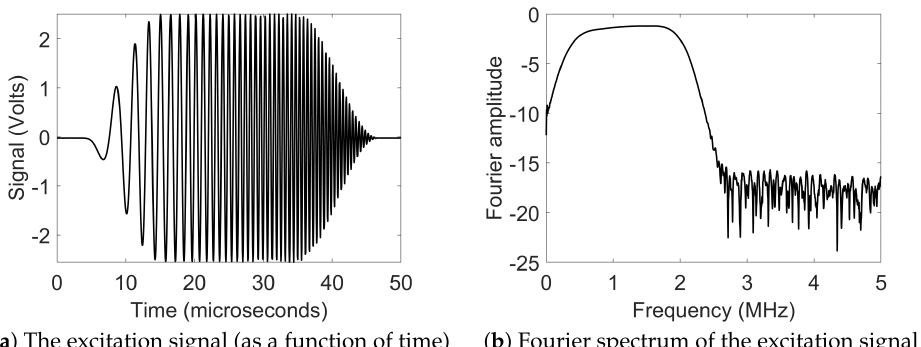
Figure 2. Chirp coded excitation signal used in the